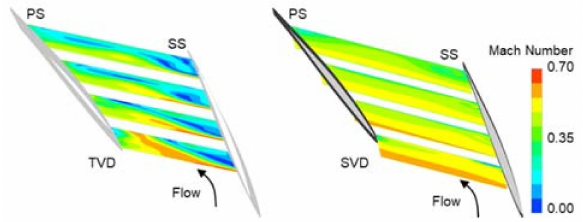
Figure 10. Distribution of Mach number in diffuser passages ( ϕ = 0.7 Q d ).